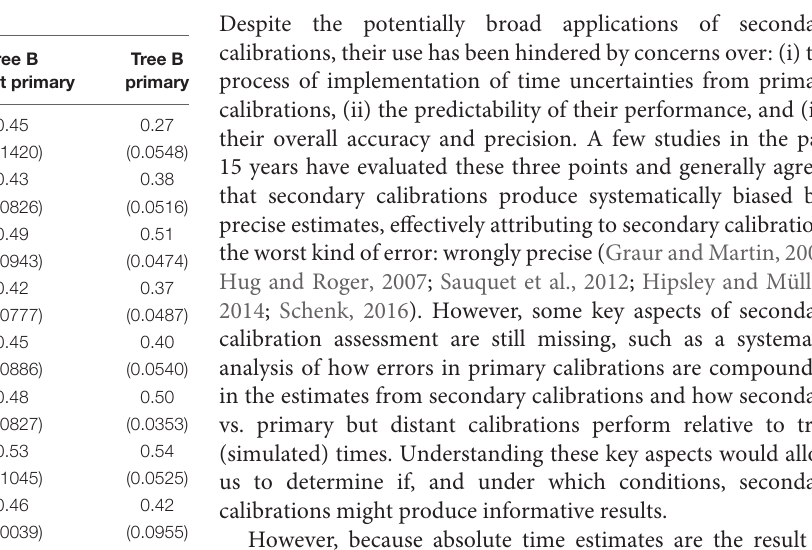
TABLE 3 | Confidence interval (CI) precision relative to the simulated true time.